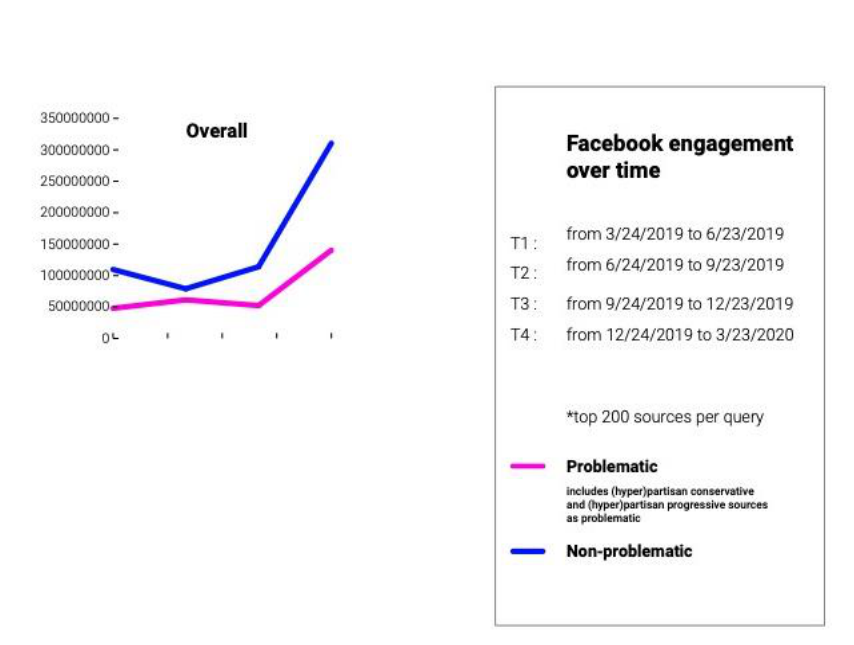
Figure 4. Facebook engagement scores of ‘fake news’ (Silverman’s original roomy definition) versus mainstream news for political candidate and social issue queries overall, March 2019 - March 2020. Source: Buzzsumo.com.